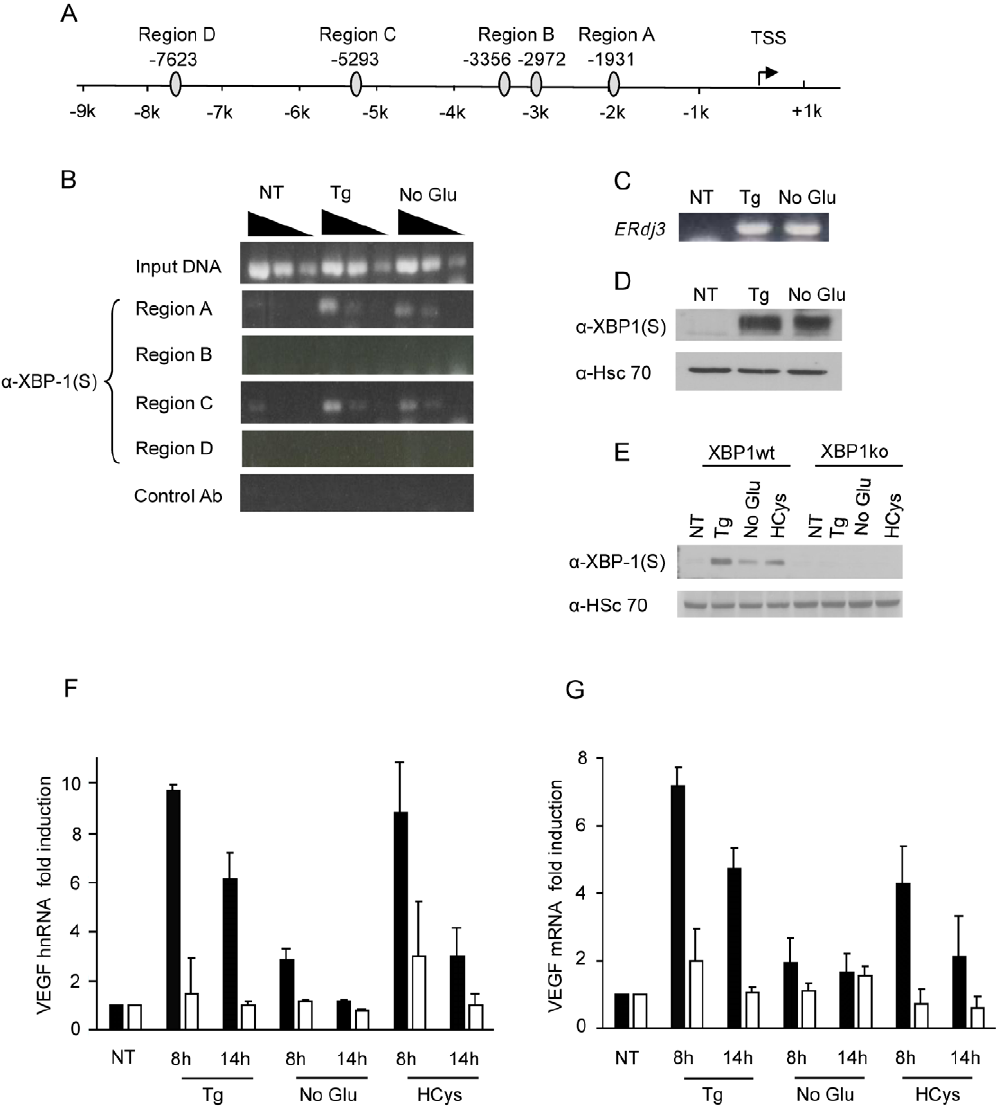
Figure 4. XBP-1 binds to two regions in the rat VEGF promoter in response to ER stress and contributes to increasing VEGF transcription rate. ( A ) Potential XBP-1 sites in the rat VEGF promoter. ( B ) Cross-linked chromatin from C6 cells that were untreated (NT), thapsigargin-treated (Tg), or incubated in no glucose media (No Glu) for 8 hours were immunoprecipitated with anti-XBP-1 or with a control antiserum (anti-BiP). Ten-fold serial dilutions of precipitated chromatin and input controls were used for PCR amplification. ( C ) As a positive control, primers spanning the XBP-1 binding region on the ERdj3 promoter were used to PCR amplify the anti-XBP-1 precipitated chromatin ( D ) XBP-1(S) protein levels were detected in C6 cells treated with Tg and No Glu media using Western blot analysis. ( E ) XBP-1 wild-type (black) or null (white) MEFs were untreated (NT), thapsigargin-treated (1 m M), treated with media lacking glucose (No Glu) or homocysteine-treated (10 mM) for 14 hours. Cell lysates were prepared and XBP-1(S) was detected by western blot analysis. ( F-G ) Cells were treated as in ( E ) and total RNA from the indicated samples was subjected to qRT-PCR to quantify VEGF hnRNA ( F ) or VEGF mRNA ( G ) at the indicated time points. RNA levels were expressed relative to the control untreated samples for each line, which was set to 1. Experiments were performed in triplicate (values are mean 6